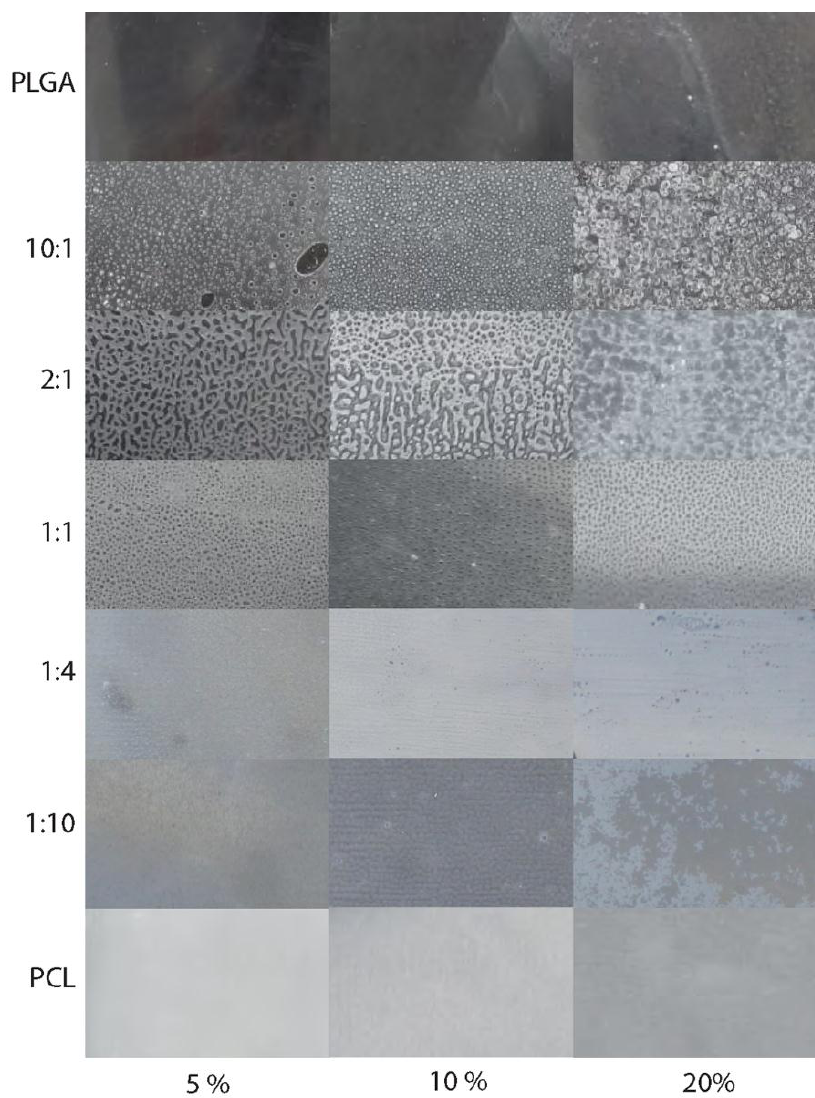
Figure 3. Surface of the thin films. Matrix showing the casted thin films with differing ratios of PLGA to PCL. From top to bottom the PCL content in the films increases, from left to right the valganciclovir content increases from 5% over 10% to 20% drug added. The following polymer ratios are shown: Pure PLGA (row 1), PLGA:PCL = 10:1 (row 2), 2:1 (row 3), 1:1 (row 4), 1:4 (row 5), 1:10 (row 6) and pure PCL (row 7). A phase